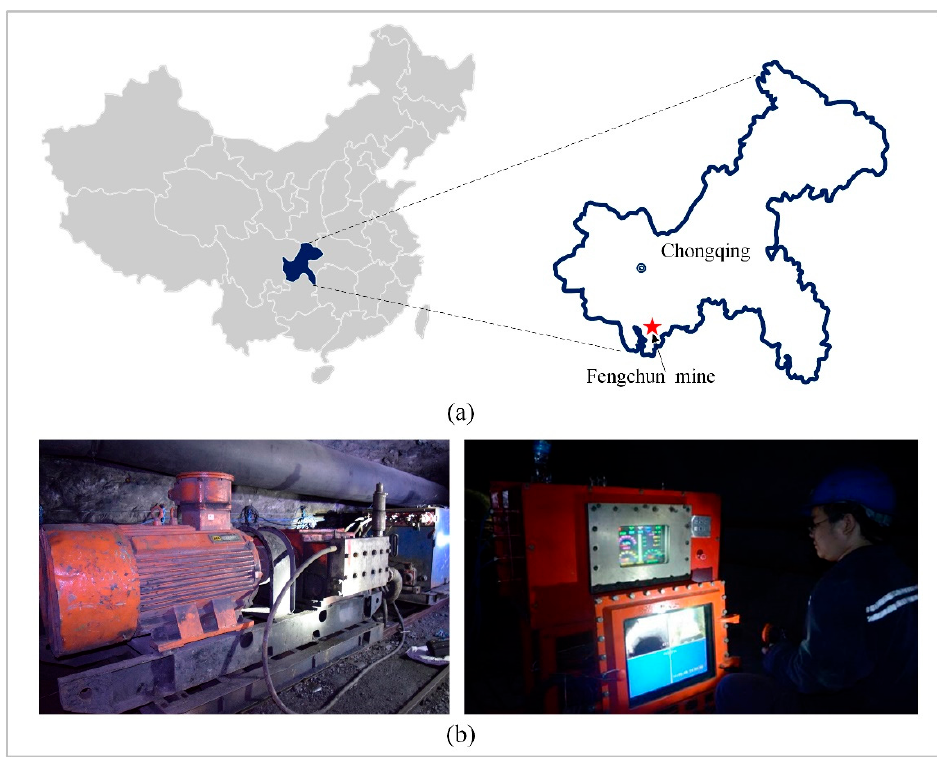
Figure 4. Field experimental site of directional hydraulic fracturing: ( a ) location of Fengchun mine in Chongqing, Southwest China and ( b ) the BRW200 / 56 high-pressure pump and intelligent control device. Table 1. Main parameters for the thermo-hydro-mechanical (THM) coupling simulation.